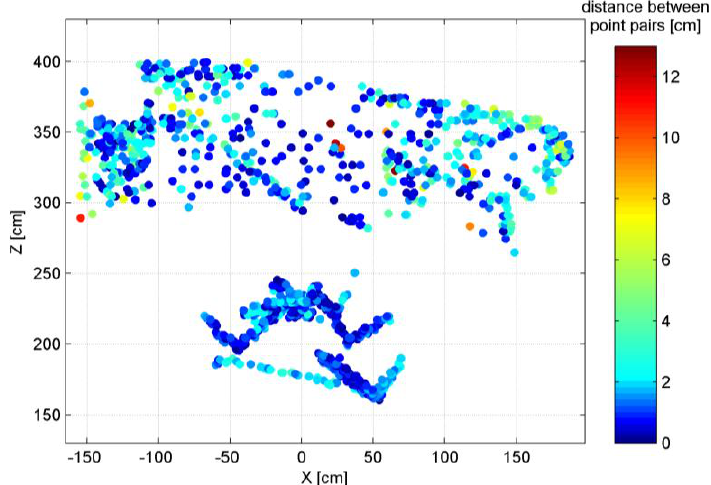
Figure 8. Distribution of point pair distances in the X-Z plane.